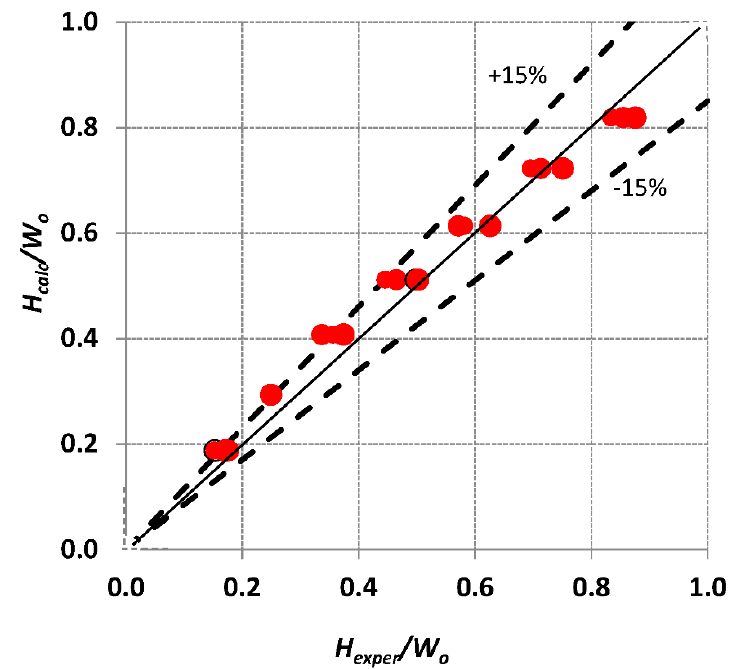
Figure 9. Comparison between experimental and calculated by Equation (2) liquid film thickness, H, normalized with respect to the channel width for the various non-Newtonian liquids, liquid flow rates and inclination angles tested.